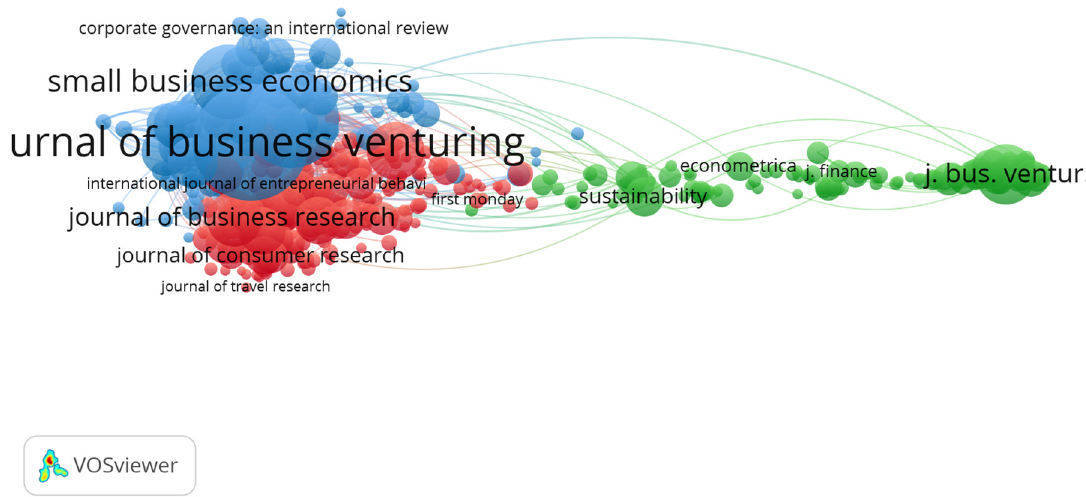
Figure 10. Co-citation analysis of sources.